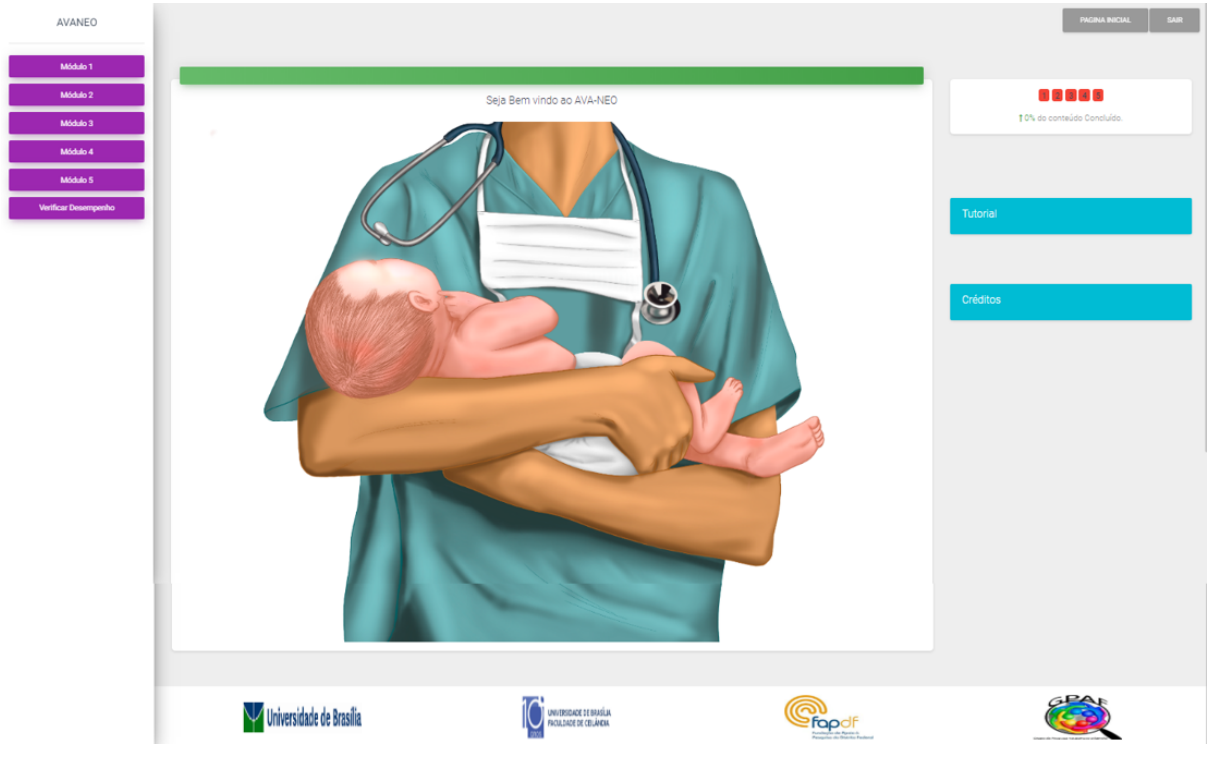
Figure 2. Main menu of the virtual learning environment.